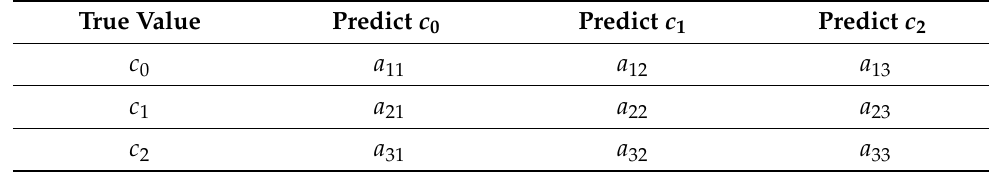
Table 1. The results of different